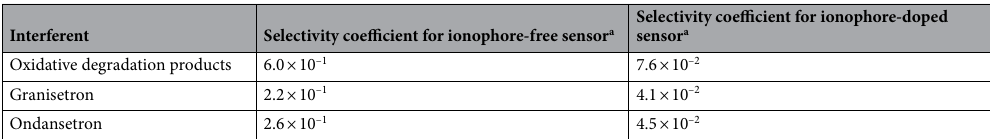
Table 2. Potentiometric selectivity coefficient ( K solutions method. a Average of three separate